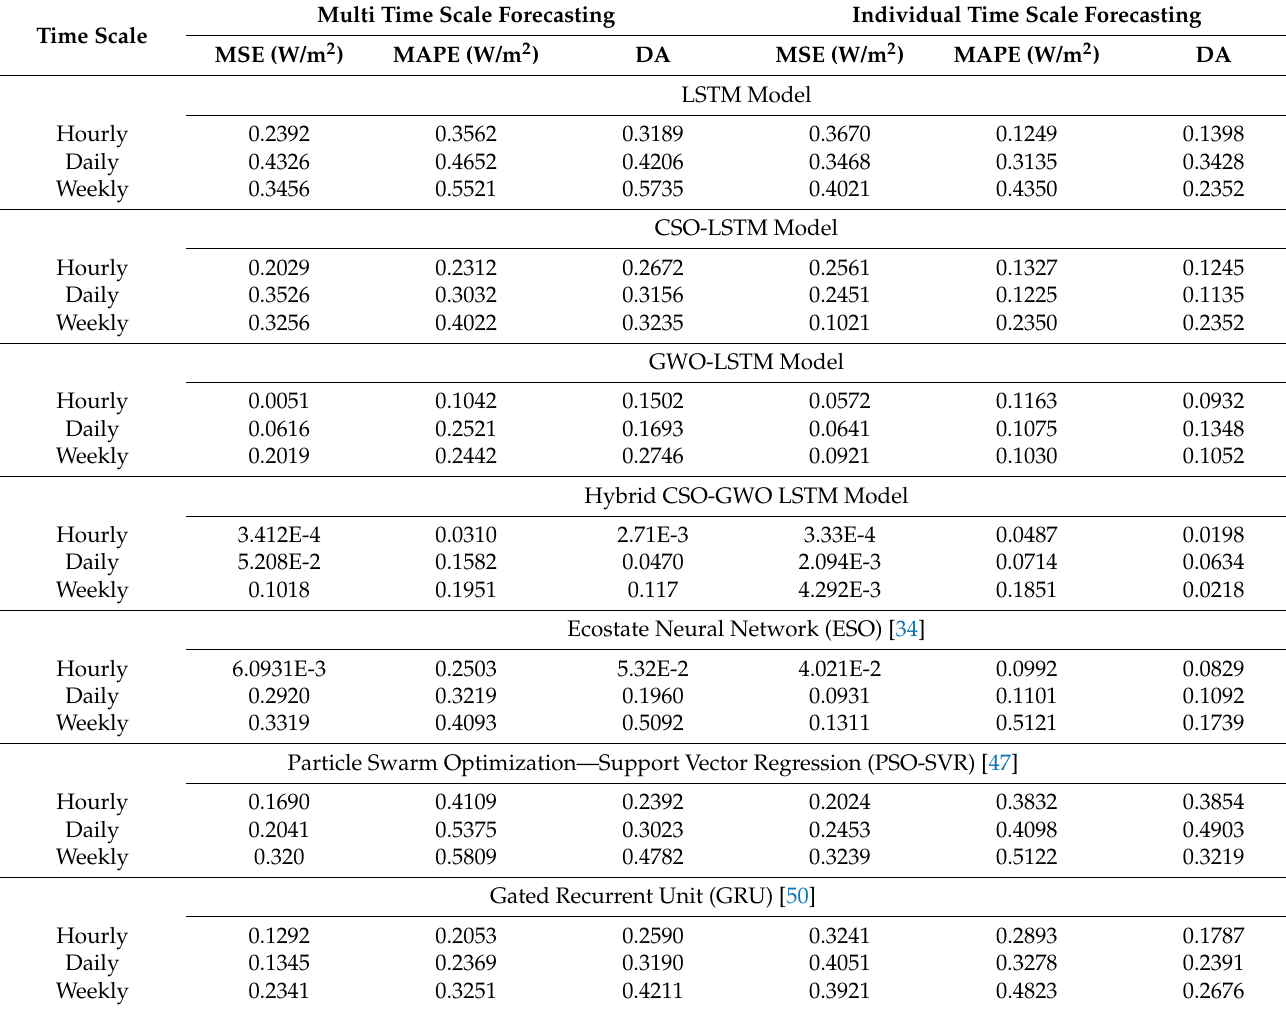
Table 2. The performance metric results of the proposed